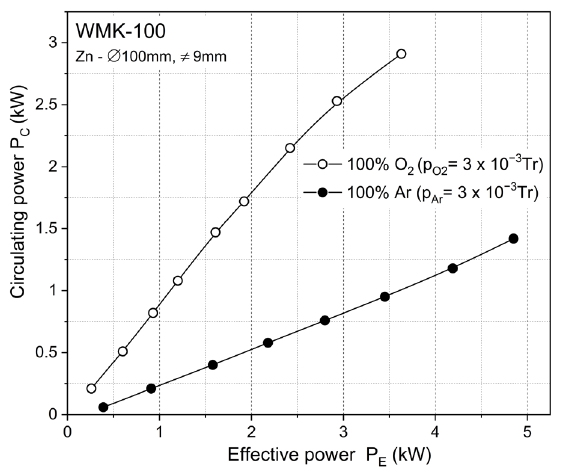
Figure 1. Dependence between effective power (P E ) and circulating power (PC) measured during the sputtering of Zn target in Ar (pure metallic target surface—metallic mode) and O 2 atmosphere (fully oxidized target surface—dielectric mode).